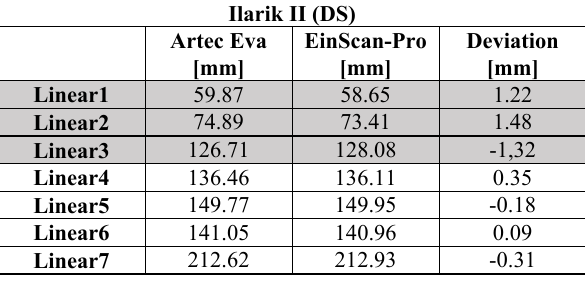
Table 5. DS analysis of the “Olla” model